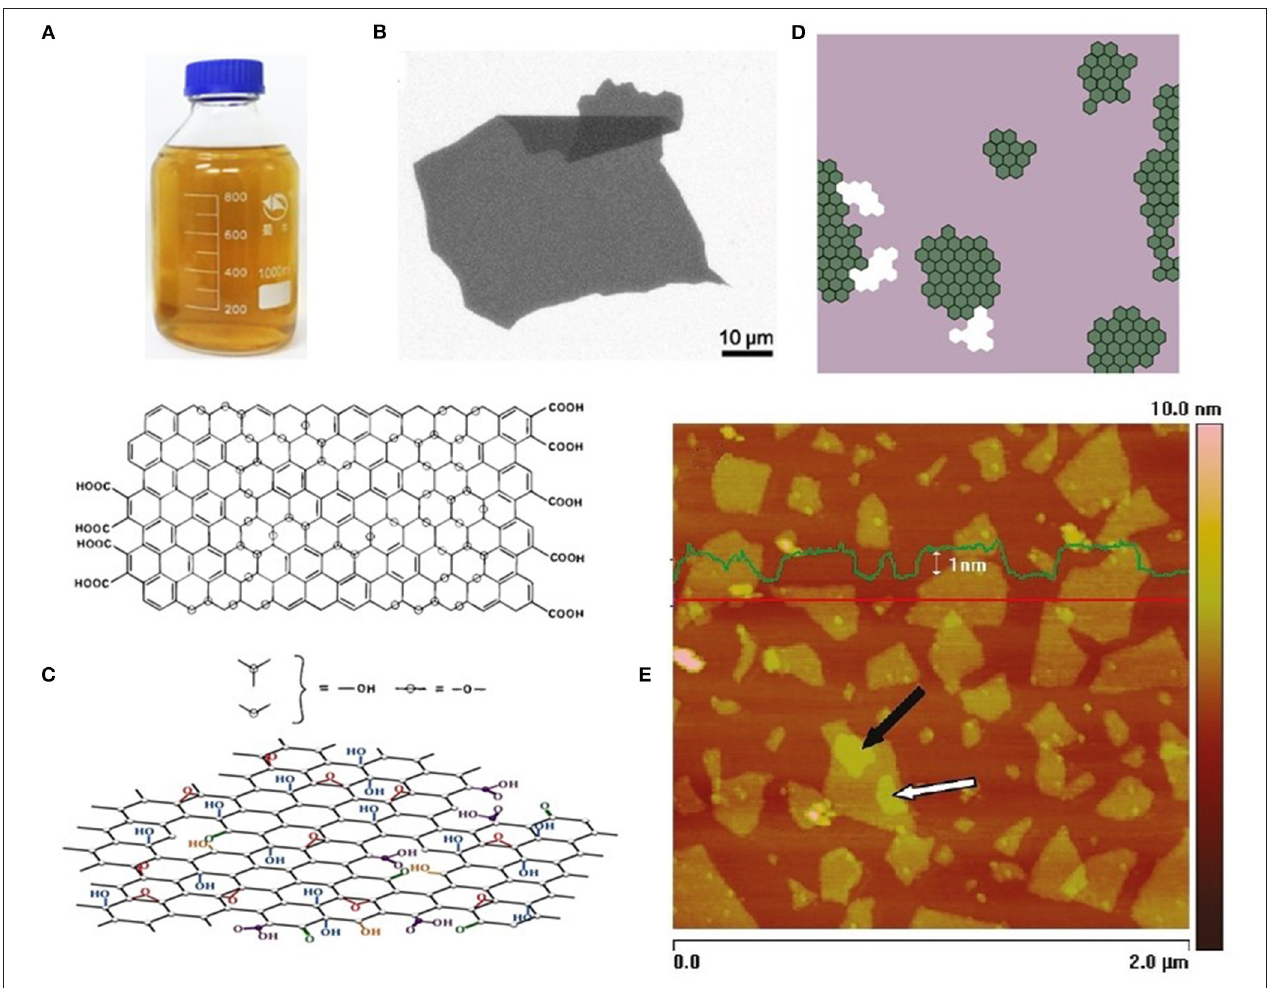
FIGURE 1 | Forms and structure of GO. (A) Aqueous dispersion of GO. Adopted with permission from Dong et al. [11] Copyright 2017ACS. Inc. (B) SEM image of large GO sheet on Si/SiO 2 substrate. Adopted with permission from Marcano et al. [ 9] Copyright © 2010 ACS. (C) Scheme of GO structure accordingly to HRTEM data Ericson et al. [ 13] of single layer suspended sheet of GO. Pristine graphene regions are indicated by green hexagons, regions containing oxygen functionalities indicated in magenta and holes in basal plane marked by white approximate size is 8 x 8 nanometers. (D) Schematic structure of GO accordingly to Lerf-Klinovski model variations indicating ambiguity regarding the presence of carboxylic acids (top) or ester of tertiary alcohol, and ketone groups at the periphery of the basal plane (bottom), accordingly to Gao et al. [ 14]. Adopted with permission from Lerf et al. [15] Copyright © 1998 ACS. (E) AFM image of GO particles on HOPG substrate. Superimposed profile of highs if taken along red line. Adopted with permission from Paredes et al. [ 16] Copyright © 2009